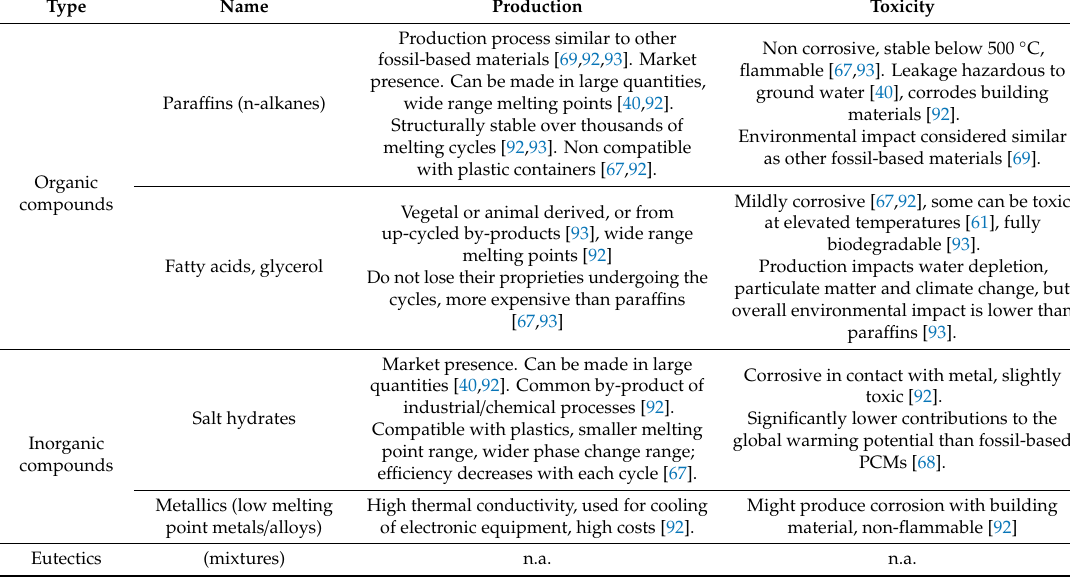
Table 2. Qualitative information on the production of thermal PCMs